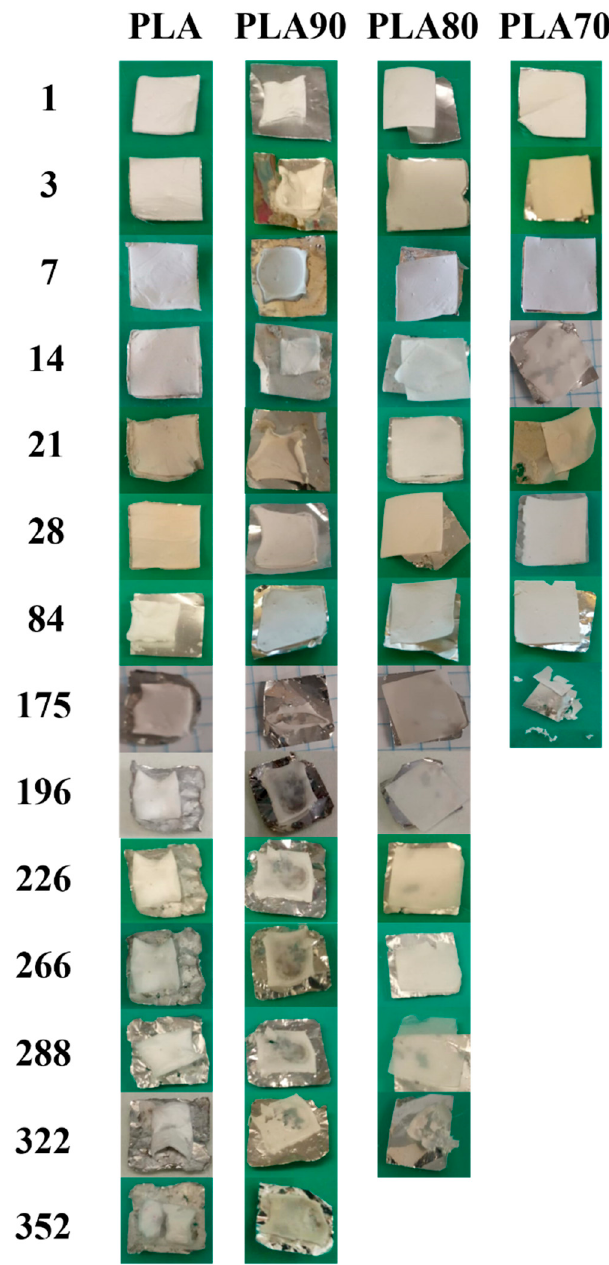
Figure 3. Visual appearance of neat PLA and each of the PLA:OLA electrospun samples after different amounts of days of immersion in PBS.